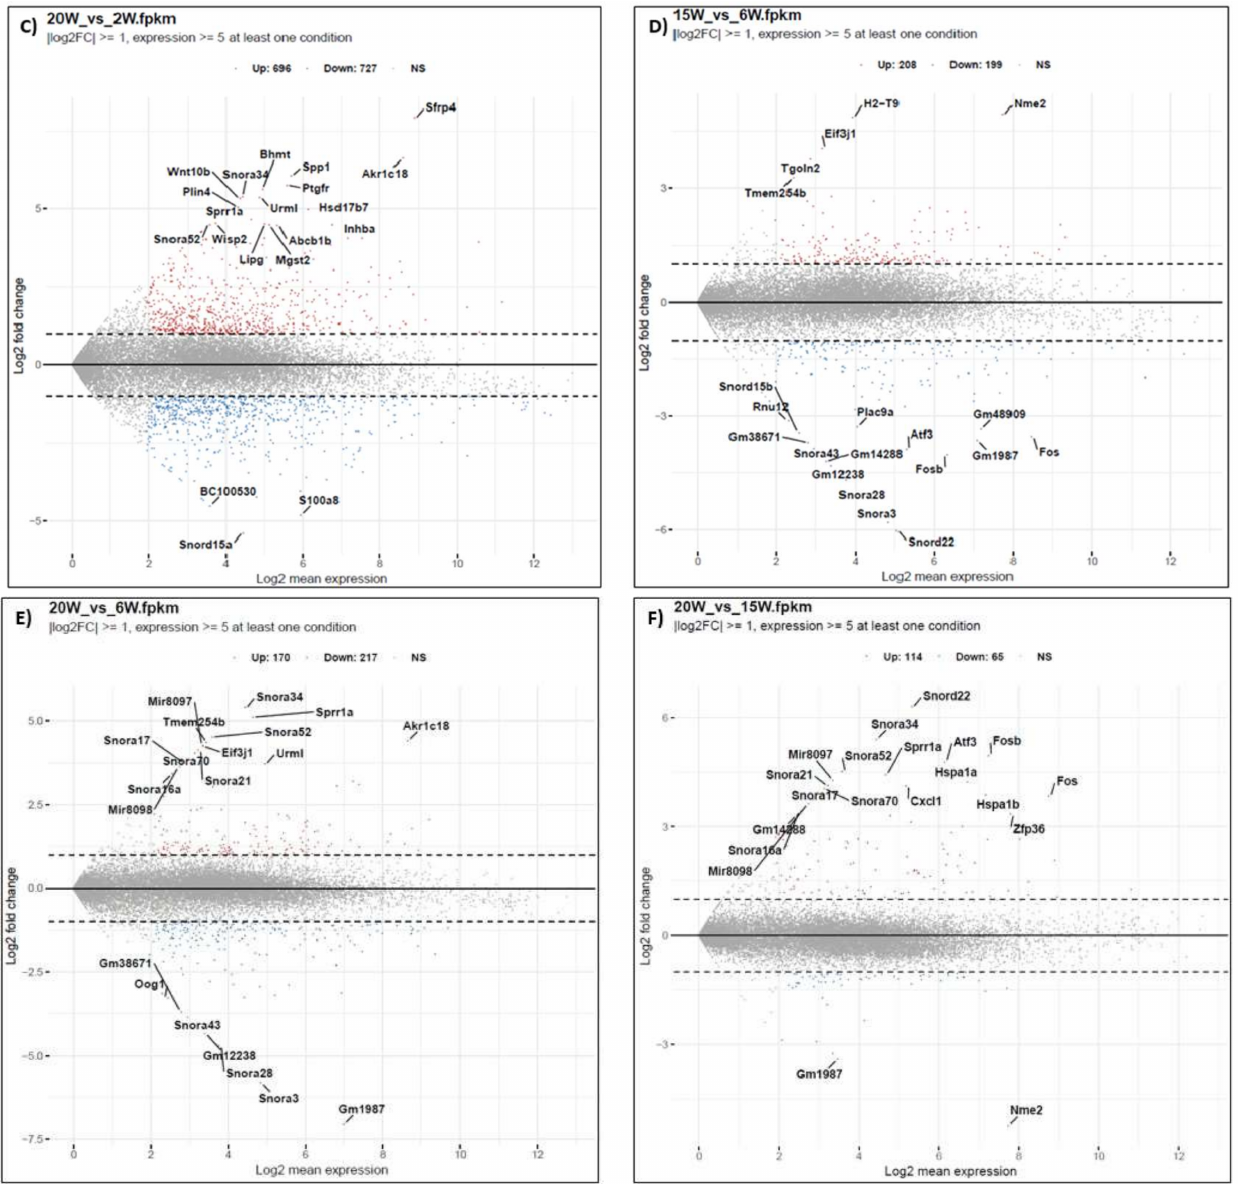
Figure 3. Up- and downregulated transcripts in the reproductively aged mouse ovary. Differently expressed transcripts among the differently aged mouse ovaries, based on the log2 fold changes and 5 fold up-and downregulation, filtered based on FPKM values. ( A ) 6 weeks (W) vs. 2 W, ( B ) 15 W vs. 2 W, ( C ) 20 W vs. 2 W, ( D ) 15 W vs. 6 W, ( E ) 20 W vs. 6 W, ( F ) 20 W vs. 15